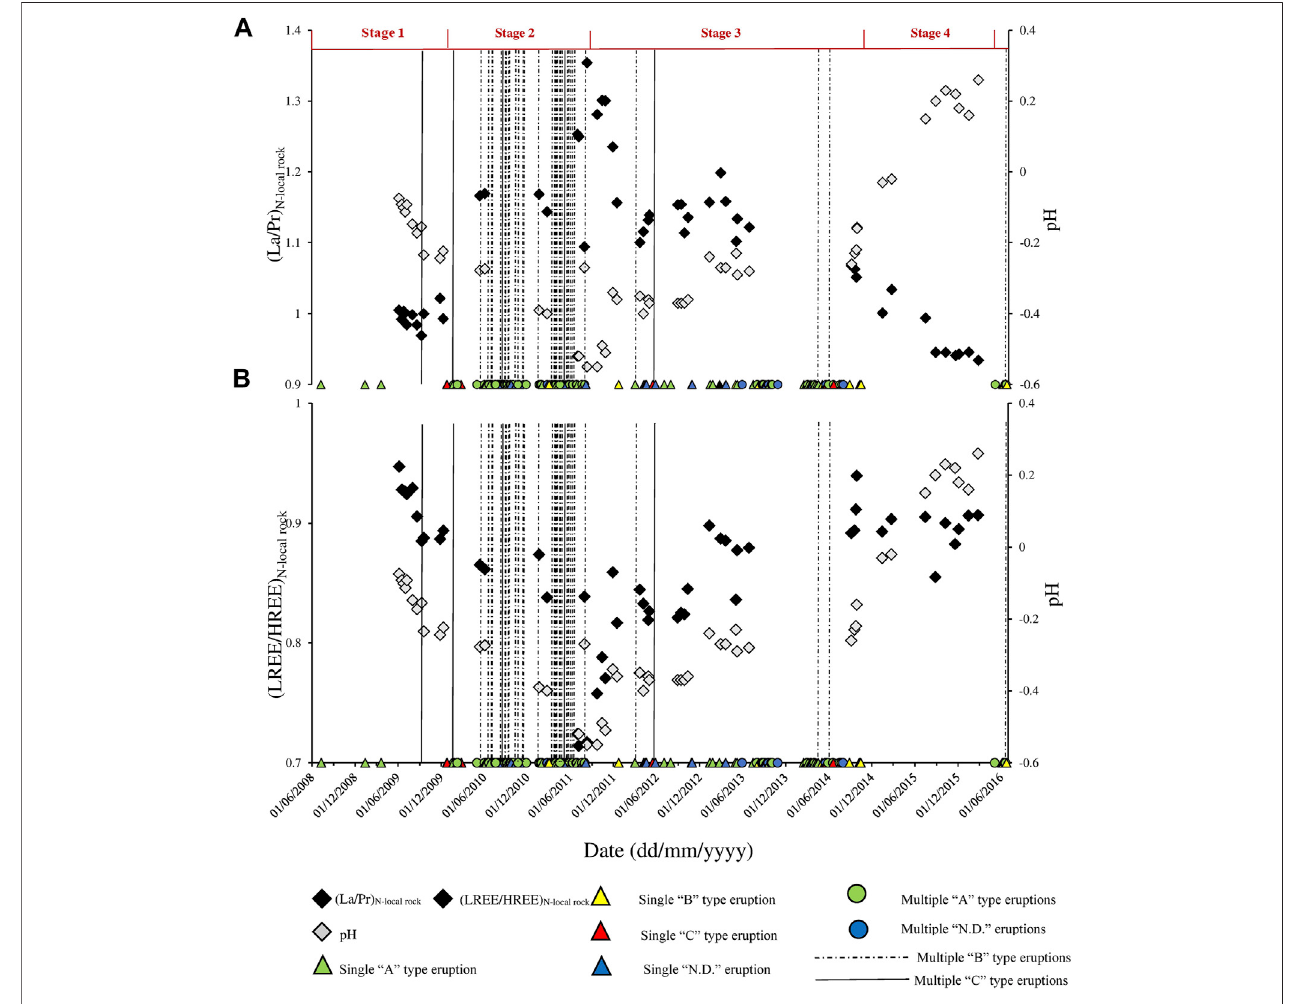
FIGURE 6 | (A) (La/Pr) N-local rock and pH vs. time. (B) (LREE/HREE) N-local rock and pH vs. time.